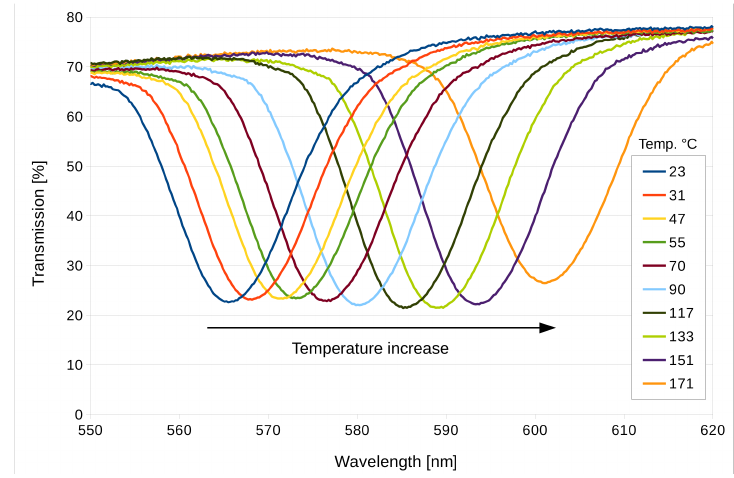
Figure 7. Transmission spectrum of the Bayfol ® HX200 reflection hologram depending on temperature.